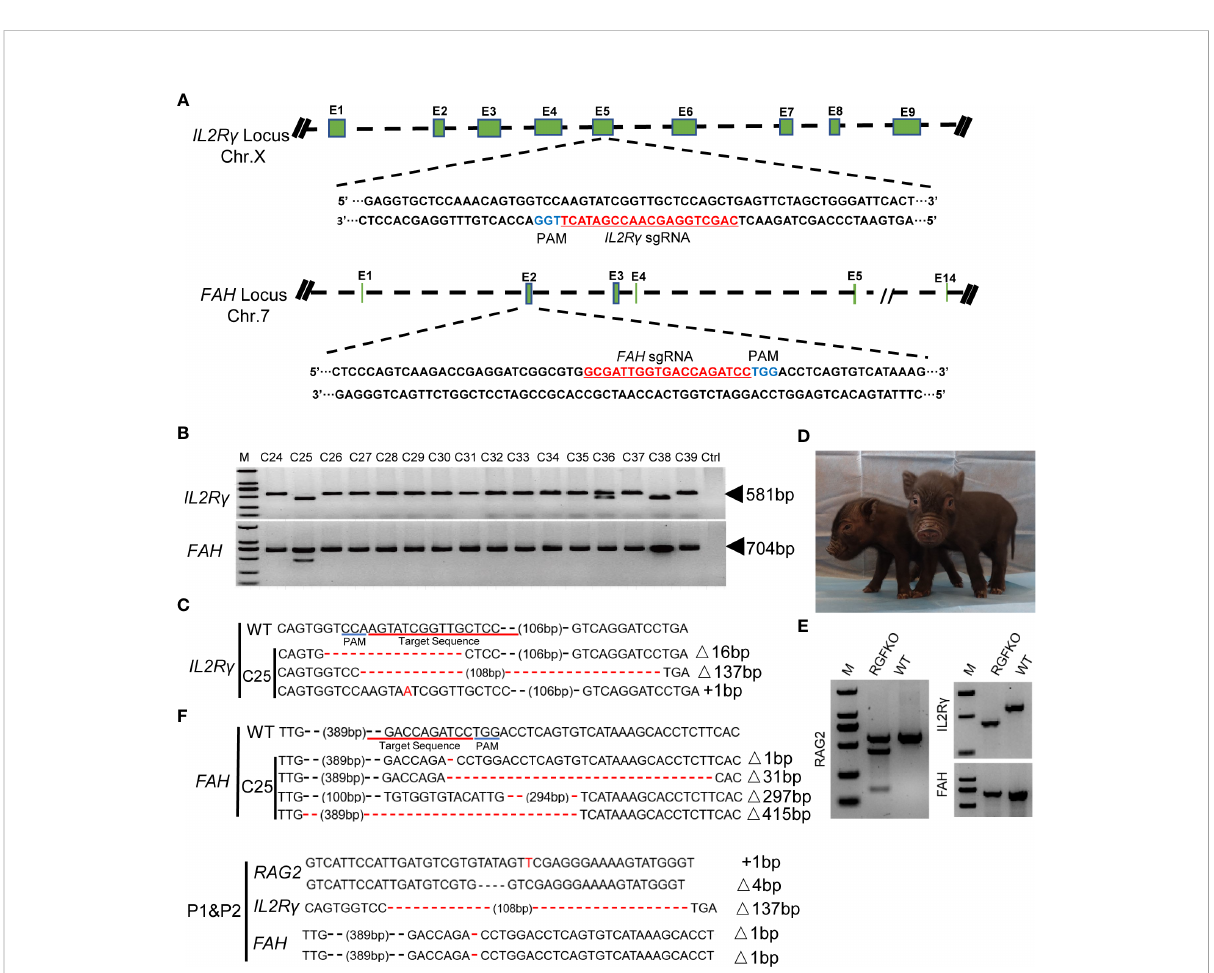
FIGURE 2 Targeted disruption of IL2R g and FAH by CRISPR/Cas9. (A) Endogenous IL2R g and FAH loci and their sgRNA targeting site are shown. (B) Genomic DNA was obtained from 16 clones (C24-C39) after puromycin selection. IL2R g and FAH were ampli fi ed by PCR for further Sanger sequencing. Ctrl: no template control. (C) Alignment of Sanger sequencing results of clone C25 with wildtype IL2R g and FAH sequences. 16 and 137 nucleotide deletion ( D 16bp, D 137bp), and one nucleotide insertion ( + 1bp) mutations were observed in IL2R g . Deletion mutations of 1, 31, 297 and 415 nucleotides were observed in FAH ( D 1bp, D 31bp, D 297bp, D 415bp). (D) Two live RGFKO piglets (P1 and P2) were obtained after 113 days of pregnancy from surrogate sows transplanted with SCNT embryos using clone C25 as donor nuclei. (E) Representative results of T7-endonuclease I assays and gel shift assays performed on the genomic DNA of RGFKO piglet (P1). WT: Wildtype. (F) Alignment of Sanger sequencing results of RGFKO piglets (P1 and P2) in the target fragments in RAG2, IL2R g , and FAH genes. One nucleotide insertion ( + 1bp) and 4 nucleotide deletional ( D 4bp) mutations were observed in RAG2. 137 nucleotide deletion mutation ( D 137bp) was observed in IL2R g . 1 nucleotide deletion mutation ( D 1bp) was observed in